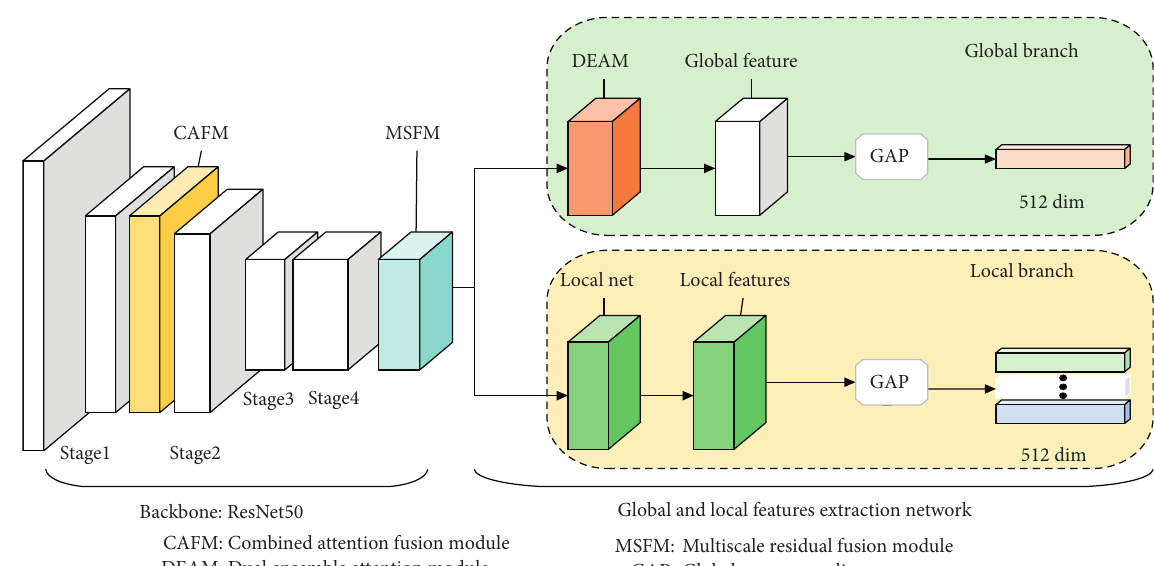
Figure 2: Schematic diagram of feature extraction network